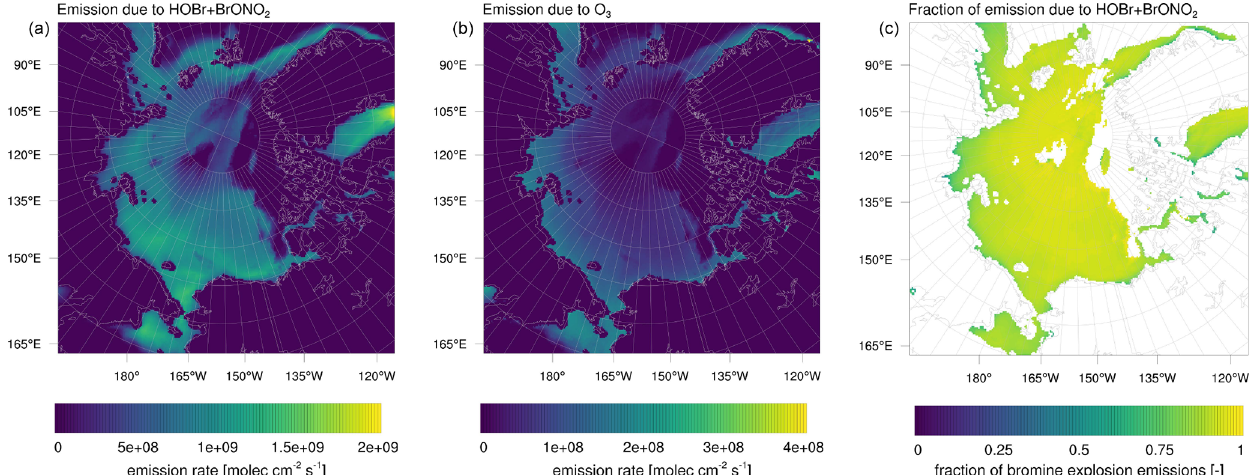
Figure 15. Emission rate of Br 2 (a) due to HOBr + BrONO 2 and (b) due to bromide oxidation by ozone from the snow surface for simulation 3, averaged over the complete simulation period. Ratio of Br 2 emissions (c) due to HOBr and BrONO 2 to total Br 2 emissions on FY ice.